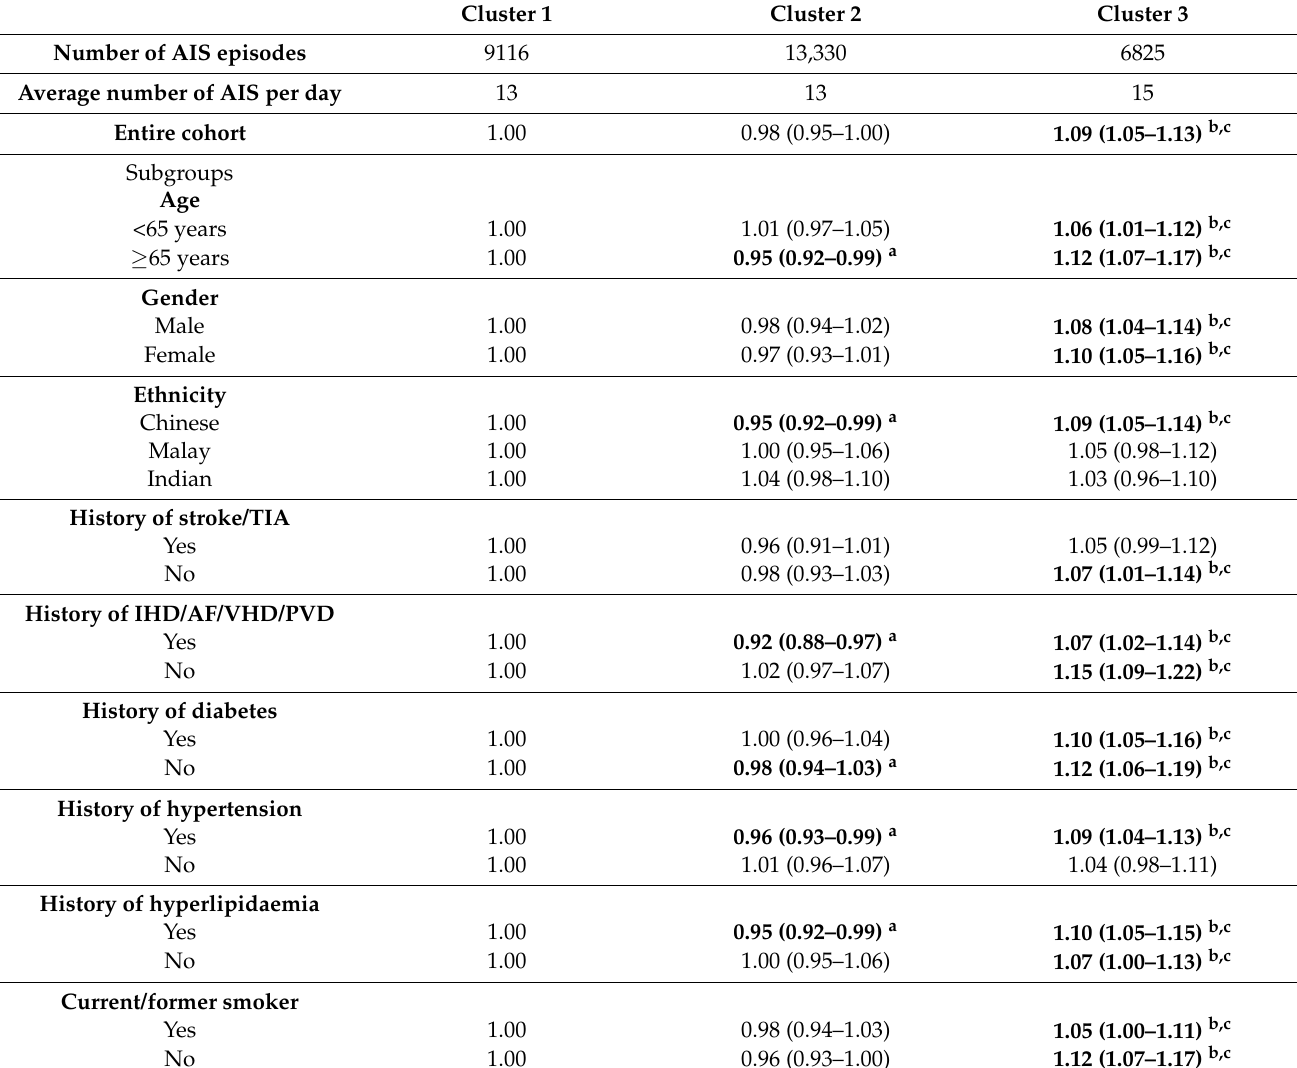
Table 2. Incidence risk ratios (IRR) of AIS in Cluster 2 (high rainfall) and Cluster 3 (high temperature and PSI) compared to Cluster 1 (high wind